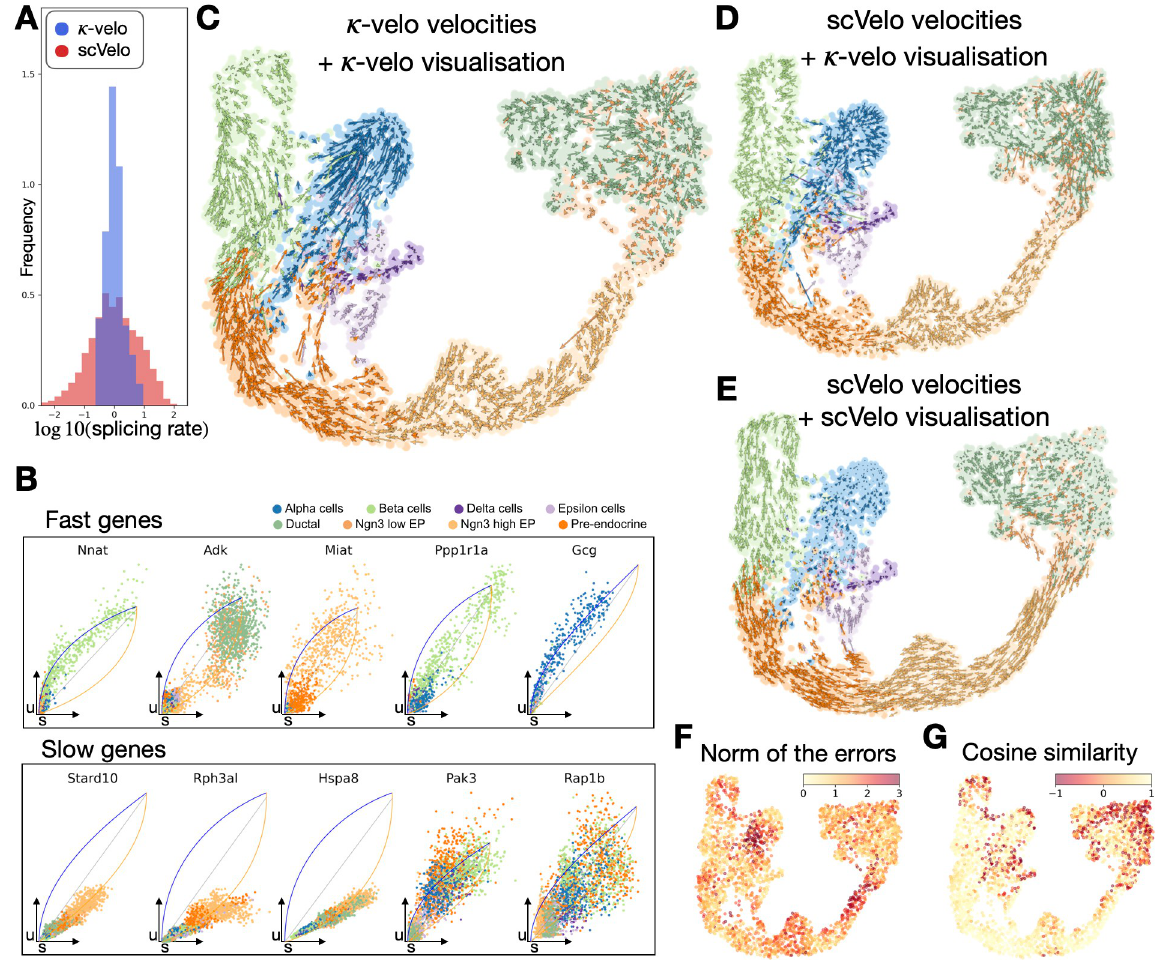
Fig 4. κ -velo on pancreas endocrinogenesis. A . Range of splicing rate β estimated by scVelo (in red) and κ -velo (in blue). B . Examples of fast and slow genes, selected according to κβ . Learned kinetics are shown by blue (upregulation) and orange (downregulation) curves. C . Velocities from κ -velo projected onto a UMAP embedding using κ -velo projection. D . Velocities from scVelo projected onto the same UMAP embedding using κ -velo projection. E . Embedded velocities as returned by scVelo. For ease of comparison, plotting style was matched to (C) and (D). F-G . Quantitative comparison of the projected velocities from κ -velo (A) and scVelo (E) on the low dimensional embedding. We return the norm of the errors in F and the cosine similarity in G .